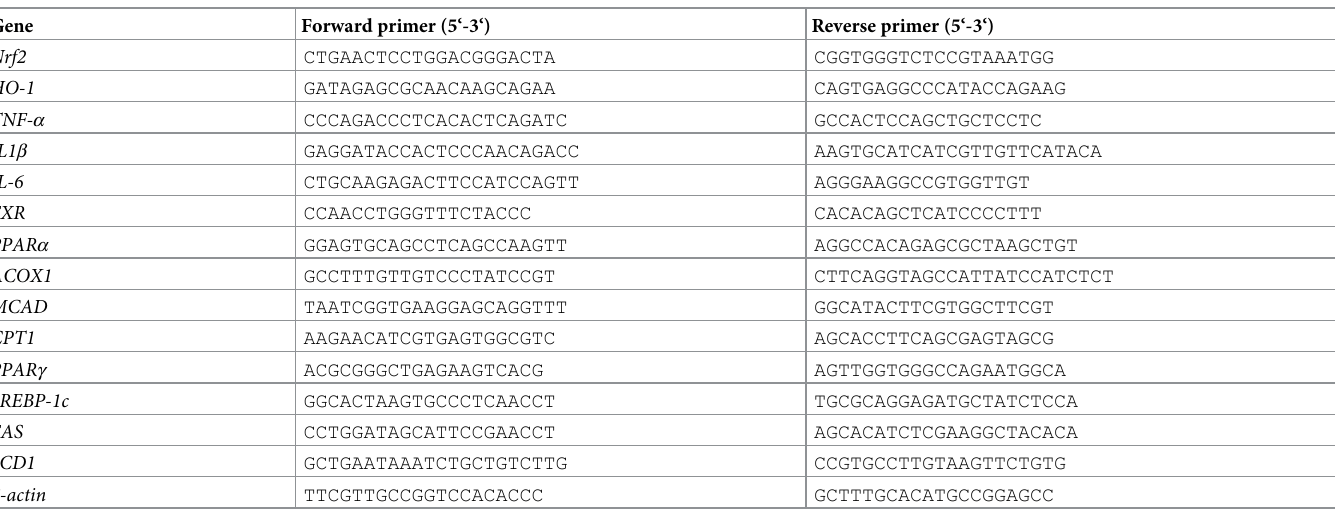
Table 1. Primers used for real-time